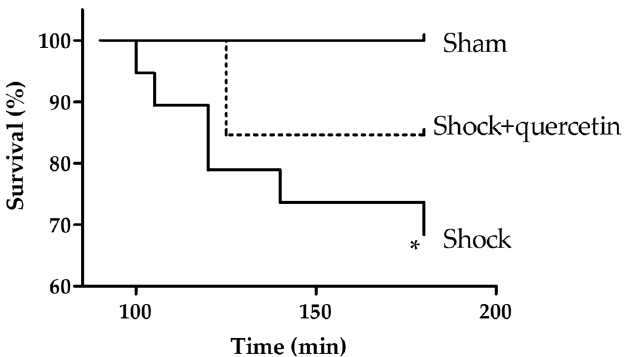
Figure 1. Kaplan–Meier survival analysis during the reperfusion period. Anaesthetized animals were submitted to shock and at time 90 they were reperfused with blood plus lactate Ringer and with vehicle or quercetin, and followed for an additional period of 90 min. * p < 0.05 vs. sham (log-rank test).